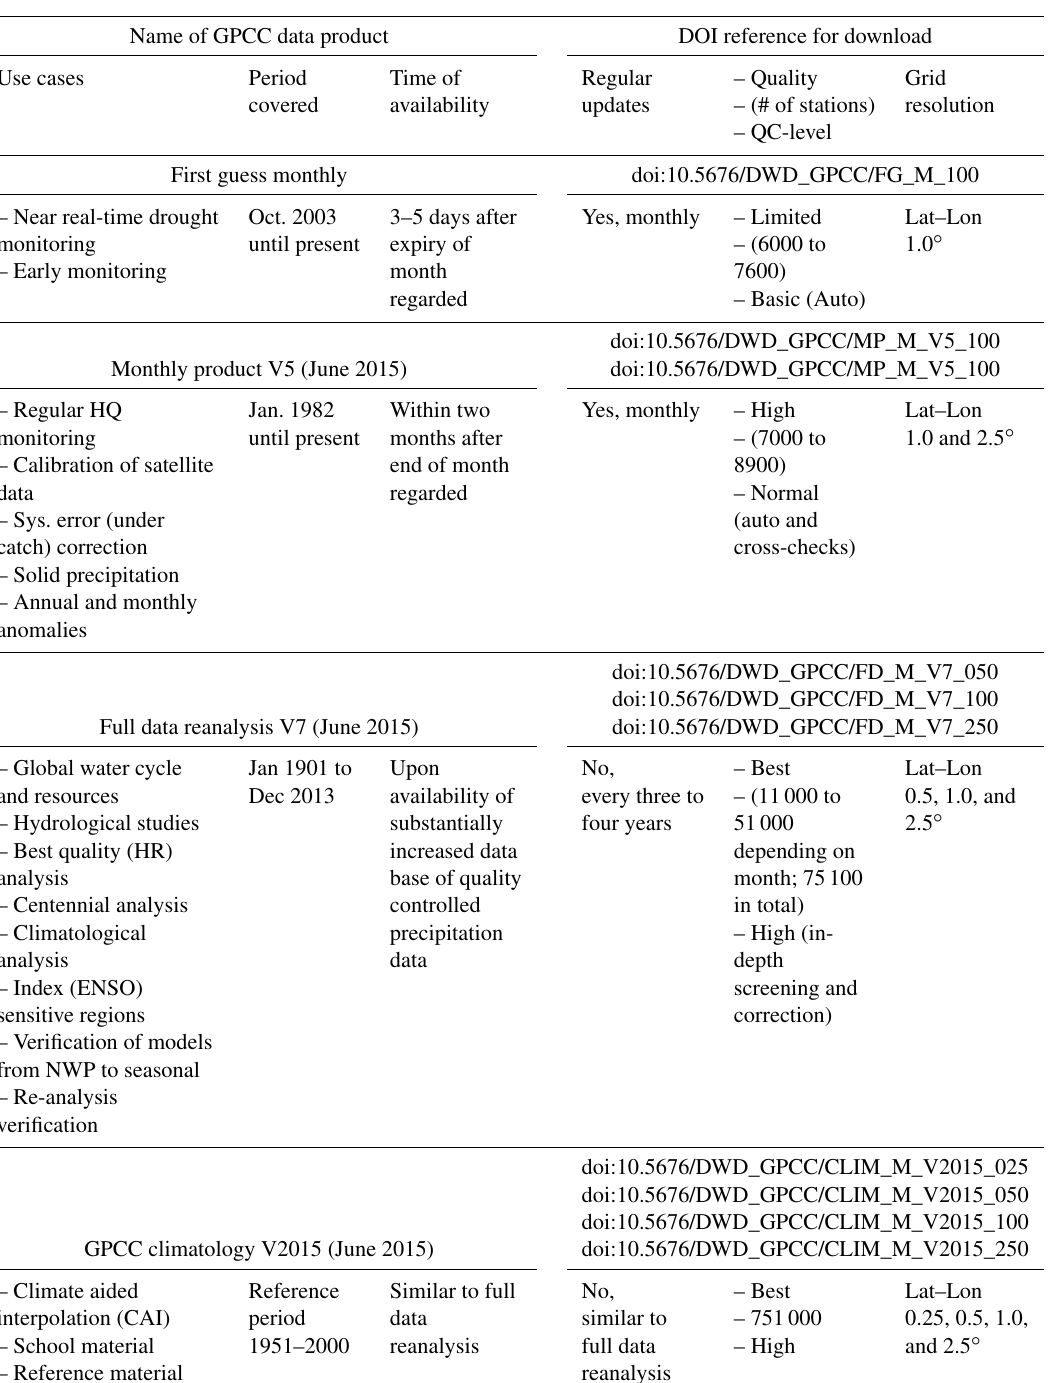
Table 1. Overview on monthly data products of the GPCC and their use